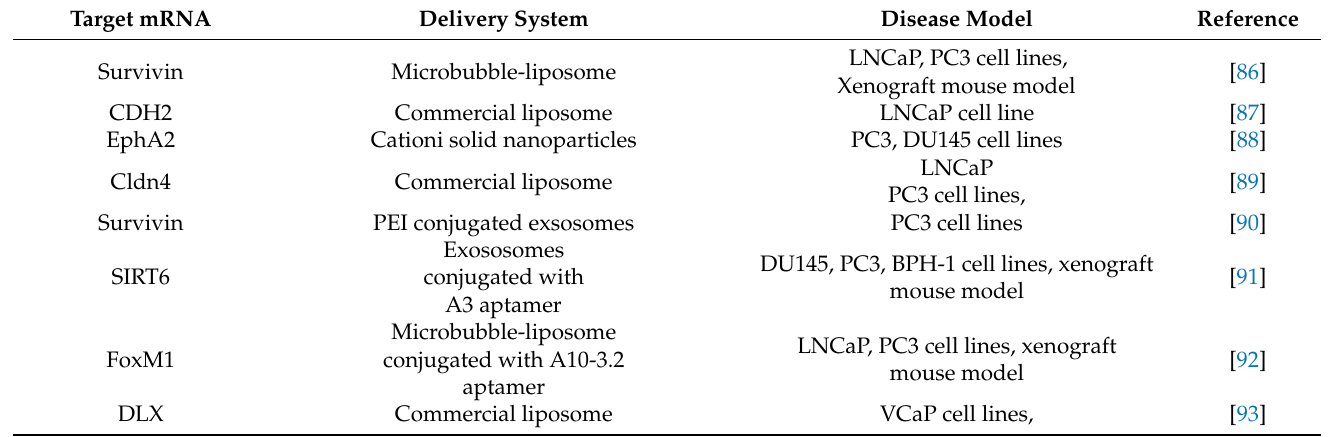
Table 3. siRNA delivery in prostate